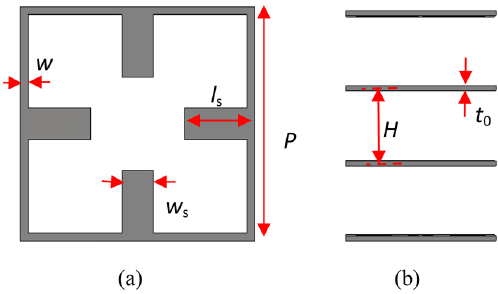
Figure 3. Geometry of the proposed unit cell to support both TE and TM polarization ( a ) top view and ( b ) side view.